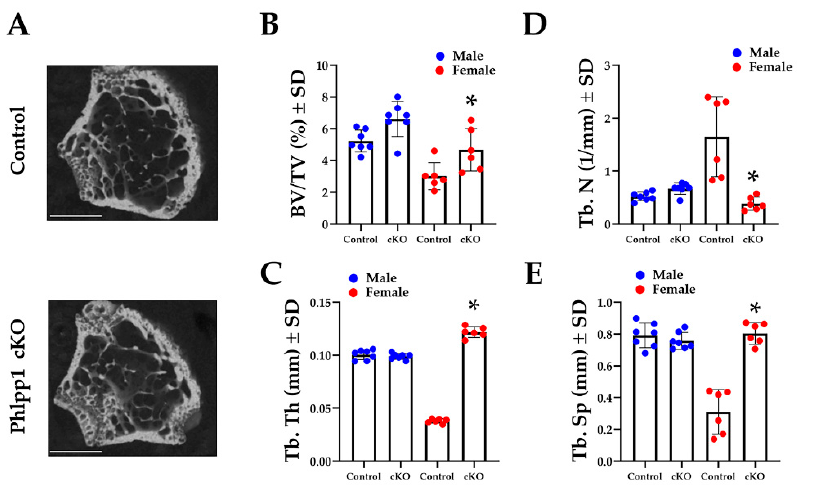
Figure 1. Conditional deletion of Phlpp1 increases bone mass of female mice. Phlpp1 cKO LysM mice and their littermate controls were aged to 12 weeks and micro-CT was performed at the distal femur. ( A ) Representative images from female mice. Scale bar is 1 mm. ( B ) Bone volume per total volume (BV/TV), * p < 0.05. ( C ) Trabecular thickness (Tb. Th), * p < 0.05. ( D ) Trabecular number (Tb. N), * p < 0.05. ( E ) Trabecular spacing (Tb. Sp), * p <